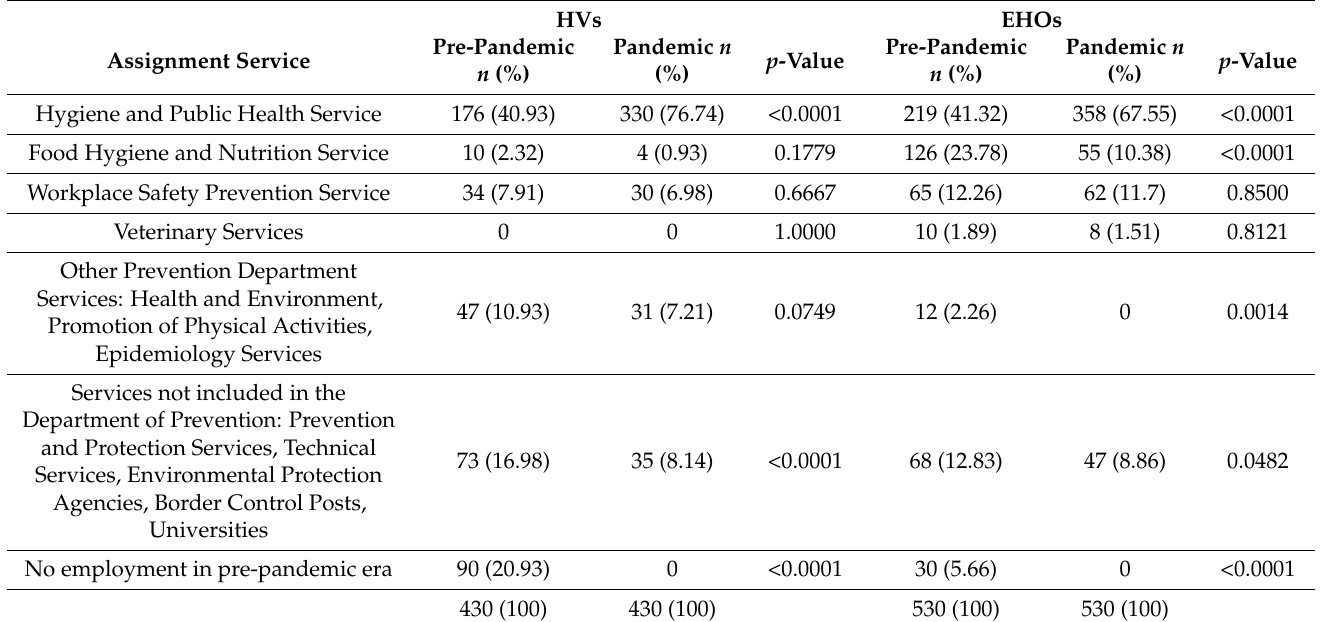
Table 3. Respondent assignment services in pandemic and pre-pandemic eras.